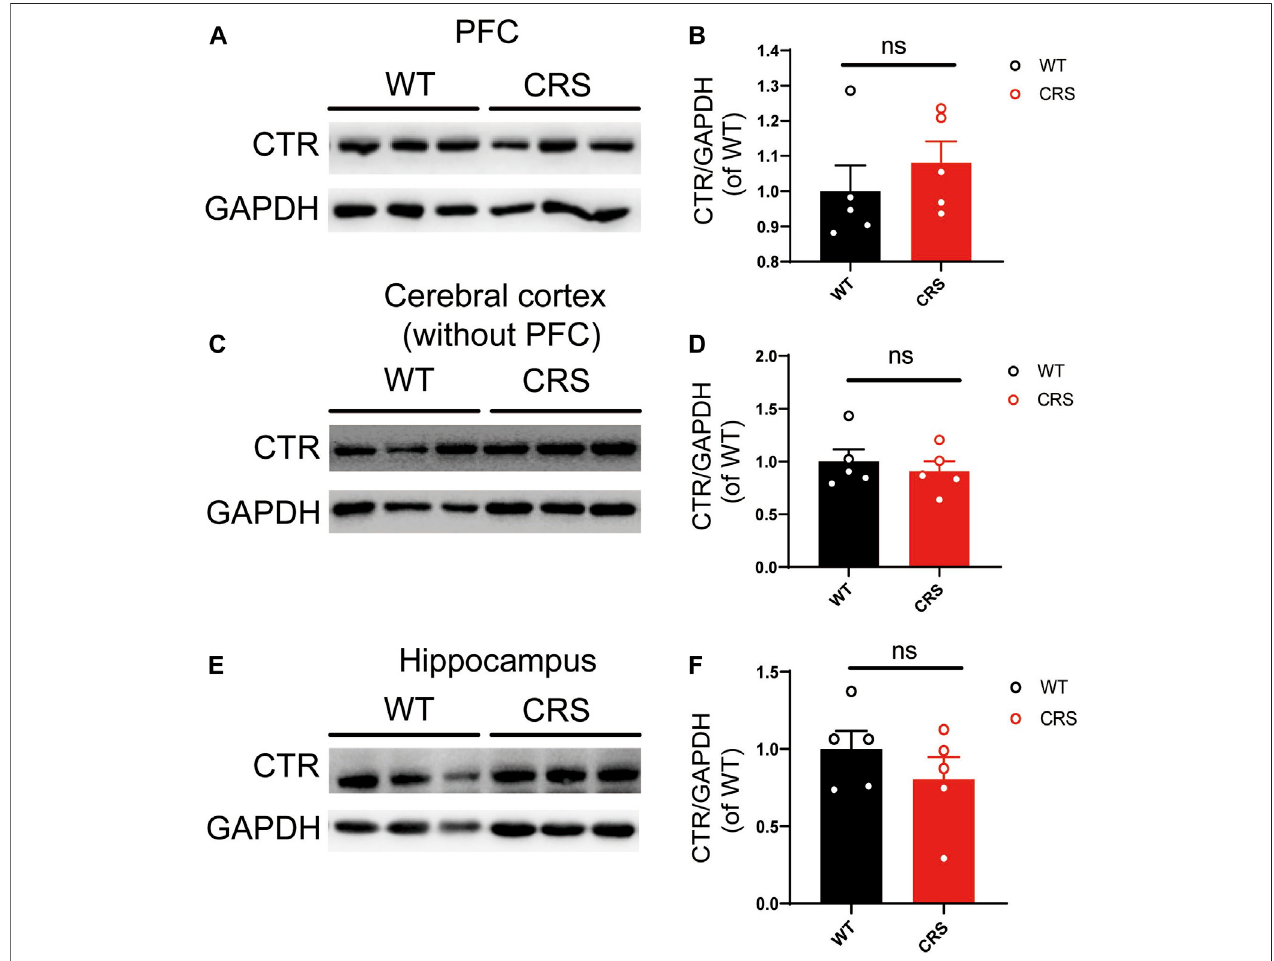
FIGURE 6 | The level of CTR was not altered in PFC, cerebral cortex (without PFC), and hippocampus. The Western blotting bands in PFC (A) . Relative CTR expression was not altered in PFC (WT: n = 5; CRS: n = 5) (B) . The Western blotting bands in the cerebral cortex (without PFC) (C) . Relative CTR expression was not altered in the cerebral cortex (without PFC) (D) . The Western blotting bands in the hippocampus (E) . Relative CTR expression was not altered in the hippocampus (F) . The data were analyzed by unpaired t -test. CTR, calcitonin receptor; PFC, prefrontal cortex; WT, wild type; CRS, chronic restraint stress.